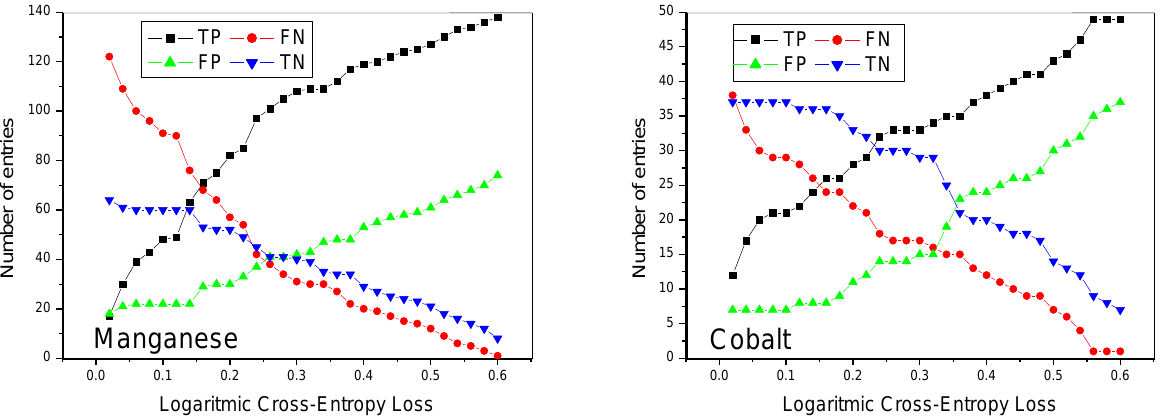
Figure 2. Number of true positives (TP), false negatives (FN), false positives (FP), and true negatives as a function of the LCEL calculated for lithiated manganese ( left ) and cobalt ( right ) oxides. In the case of cobalt, for low values of the LCEL, the false negatives are equal to the true negatives; however, as the LCEL increases, the true negatives remain constant while the false negatives decrease rapidly. Again, for LCEL values greater than 0.30, true and false negatives tend to decrease at the same rate. For this type of application, it is important, in addition to having a high number of true positives, to reduce the false positives, i.e., to avoid identifying compounds which apparently appear to belong to a determinate crystalline group and instead belong to another one. Figure 3 shows the ratio between the number of true positives (TP) and that of false positives (FP) as a function of the LCEL value.